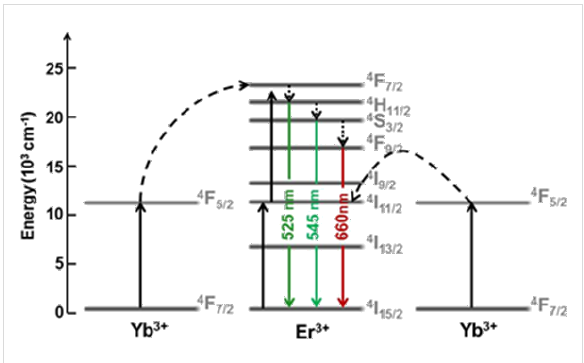
Figure 6: TGA of OM–NaYF 4 :Yb 3+ /Er 3+ nanoparticles prepared at (a) different reaction temperatures for 1 h and (b) different reaction times at 330 °C.